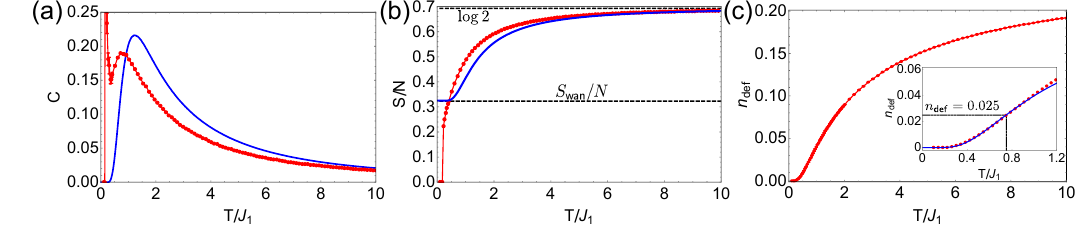
[ Eq. 1 ] with δ = 0. Figure 4: The heat capacity, entropy per site and defect triangle density for H dip Error bars are smaller than the point size unless explicitly shown. (a) The heat capacity (red) shows a broad maximum centred on T = 0.8 J , which corresponds to the freezing out of defect triangles, and 1 a sharp peak at T = 0.185 J due to a first-order phase transition. This can be compared to the case 1 of the nearest-neighbour TLIAF (blue), which shows a similar broad maximum centred on T = 1.2 J , 1 but no low-temperature phase transition. (b) The entropy per site (red) is calculated by integrating the heat capacity from infinity. The entropy passes though S wan / N , at T = 0.5 J , but does not show 1 an extended plateau, unlike the nearest-neighbour TLIAF (blue). At the phase transition there is an entropy jump of ∆ S / N ≈ 0.22. (c) The defect triangle density, n def . (Inset) At low temperatures n def follows an activated behaviour, and the blue line is the best fit to Eq. 29 with A = 0.24 and E def = 1.60 (see Appendix